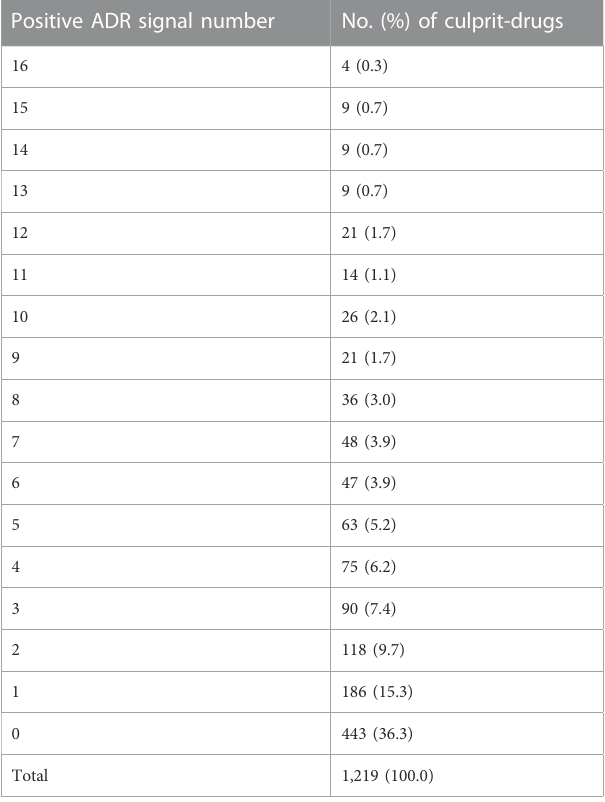
TABLE 4 Distribution of the number of positive adverse drug reaction signals. Positive ADR signal